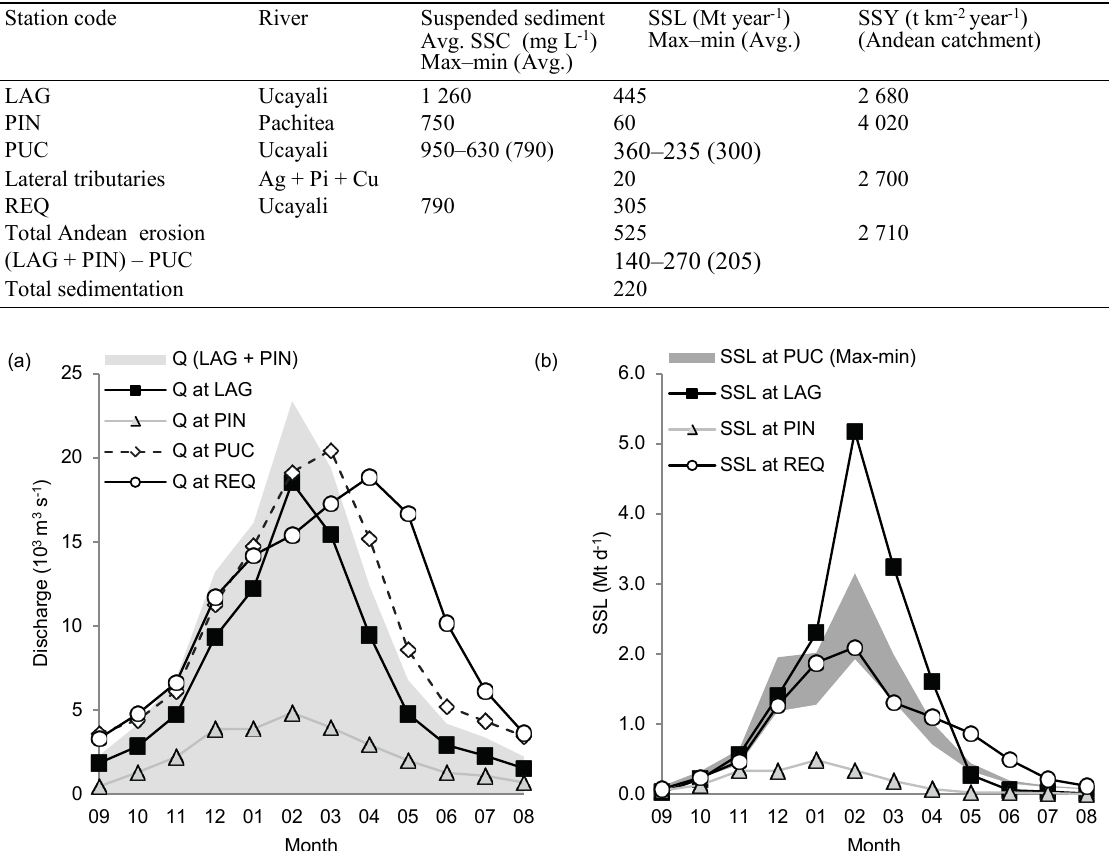
Table 2 Suspended sediment data for the Ucayali River in the period